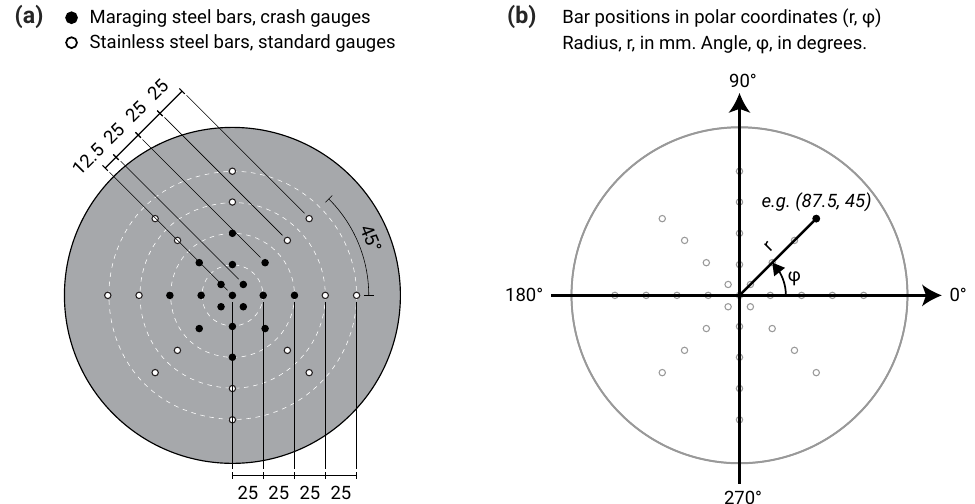
Figure 3. Central target plate pressure bar array, covering a circle with radius 100 mm. ( a ) Pressure bars within the inner 50 mm radius use high strength maraging 350 steel and specially manufactured “crash” gauges. Pressure bars outside the inner 50 mm radius use F51 stainless steel and standard strain gauges. ( b ) Polar coordinate system used to reference the bar positions, with angles measured in degrees, anticlockwise from